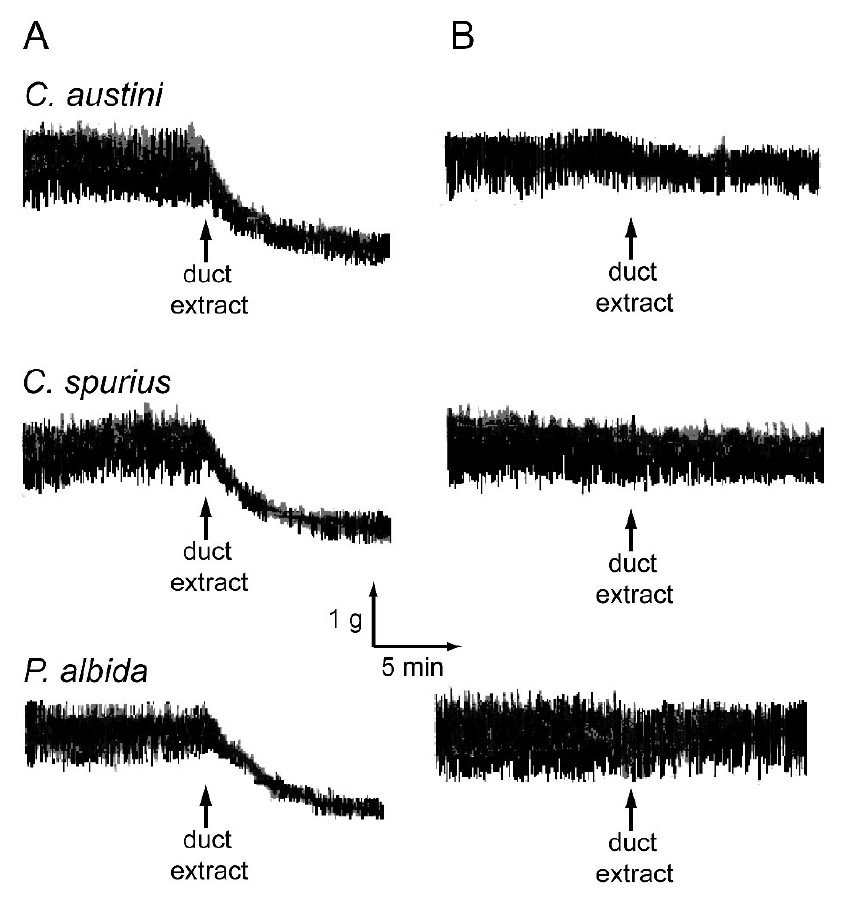
Figure 2. Tracings of guinea pig ileal contractions showing the effect of venom duct extracts from C. austini , C. spurius and P. albida (10 µg protein/mL), before ( A ) and after ( B ) the extracts were preincubated at 98°C for 30